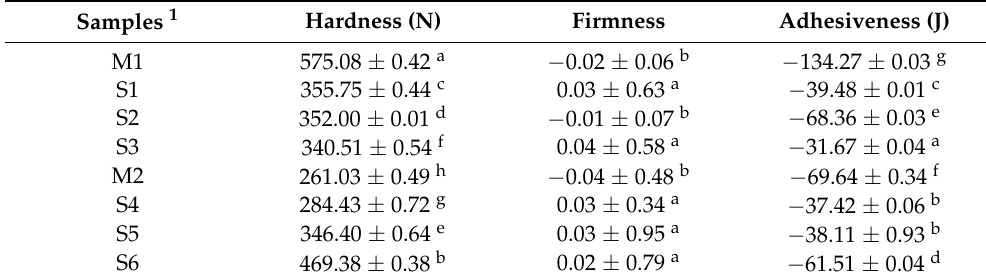
Figure 2. Steady-state flow curves of the walnut butter formulations. ( a ) M1: 3% maple syrup; S1: 3% maple syrup and 0.5% xanthan gum; S2: 3% maple syrup and 1.5% xanthan gum; S3: 3% maple syrup and 2.0% xanthan gum; ( b ) M2: 5% Jerusalem artichoke powder; S4: 5% Jerusalem artichoke powder and 0.5% xanthan gum; S5: 5% Jerusalem artichoke powder and 1.5% xanthan gum; S6: 5% Jerusalem artichoke powder and 2.0% xanthan gum. Table 3. Textural characteristics of walnuts butter